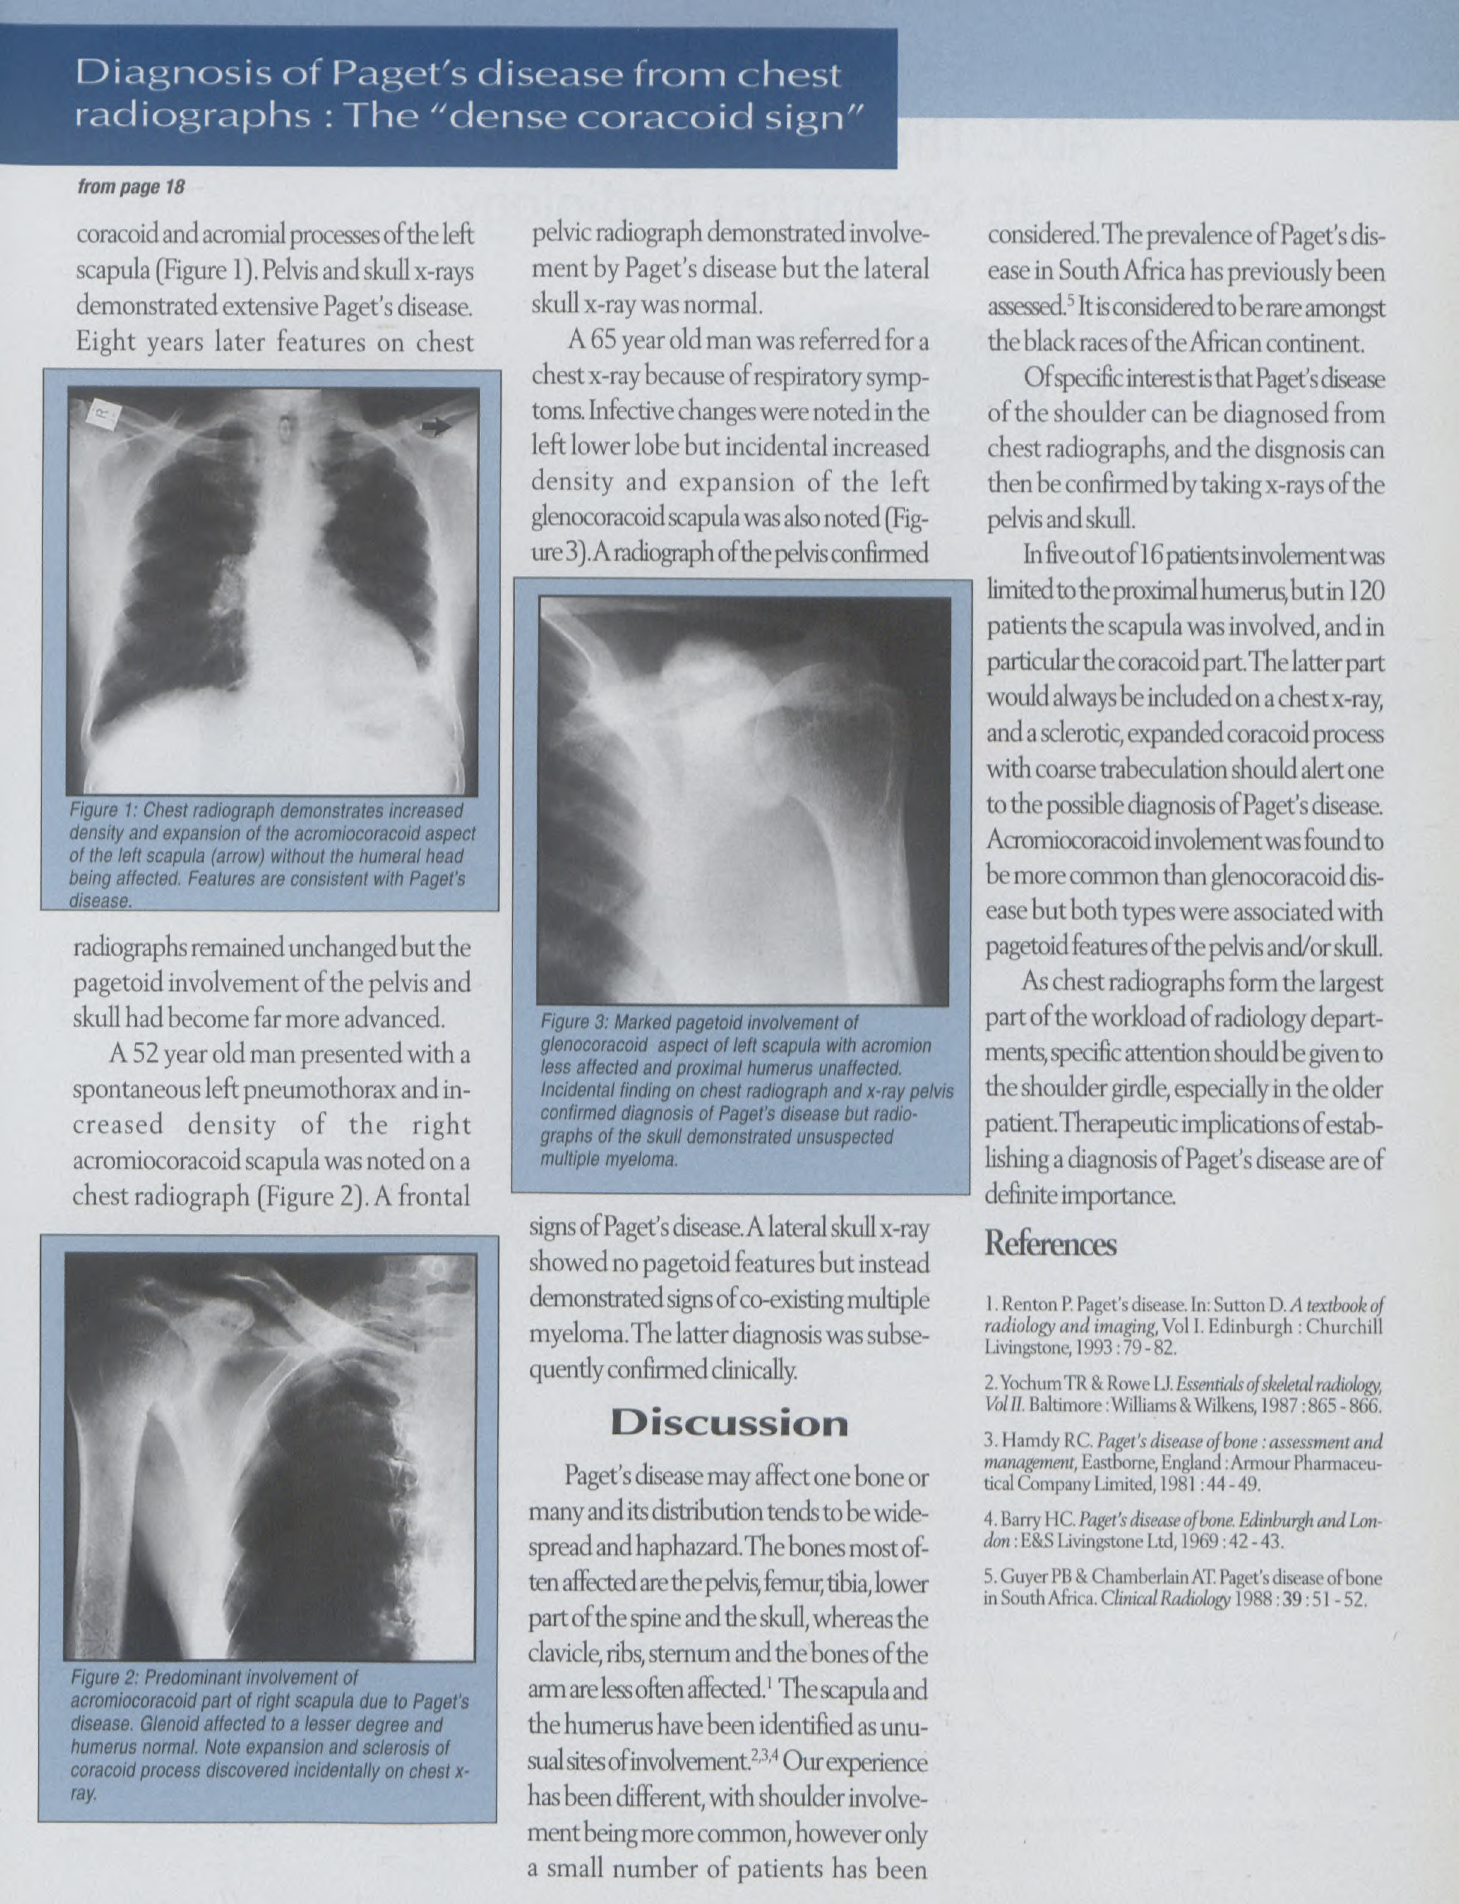
Figure 2: Predominant involvement of acromiocoracoid part of right scapula due to Paget's disease. Glenoid affected to a lesser degree and humerus normal. Note expansion and sclerosis of coracoid process discovered incidentally on chest x- ray.